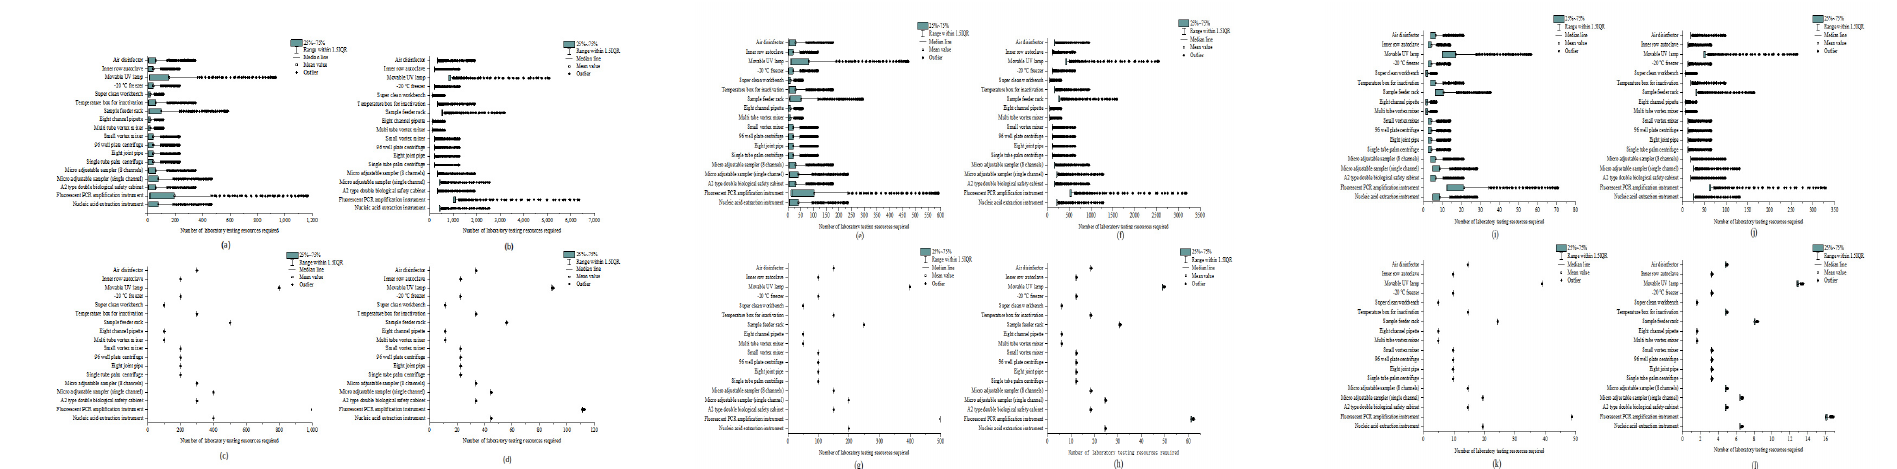
Figure 3. Laboratory testing resource requirements under different scale city scenarios 1–4; panels ( a – d ) correspond to laboratory testing resource requirements under large city scenarios 1–4; panels ( e – h ) correspond to medium city scenarios 1–4, demand for laboratory testing resources; panels ( i – l ) correspond to the demand for laboratory testing resources in small city scenarios 1–4.